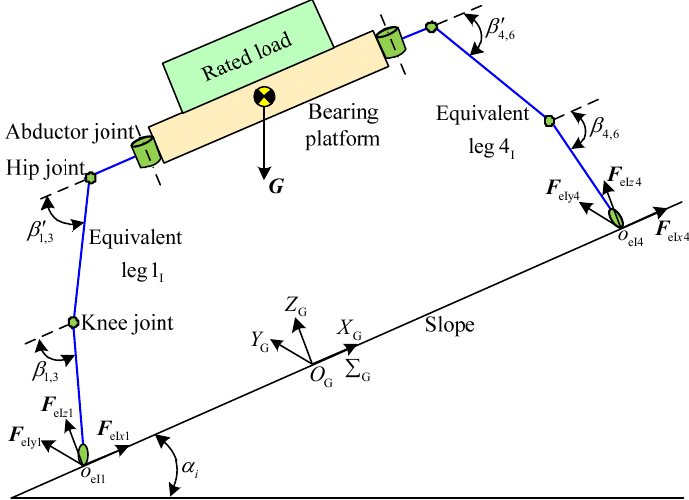
Figure 7. Equivalent model of support phase under working condition I.